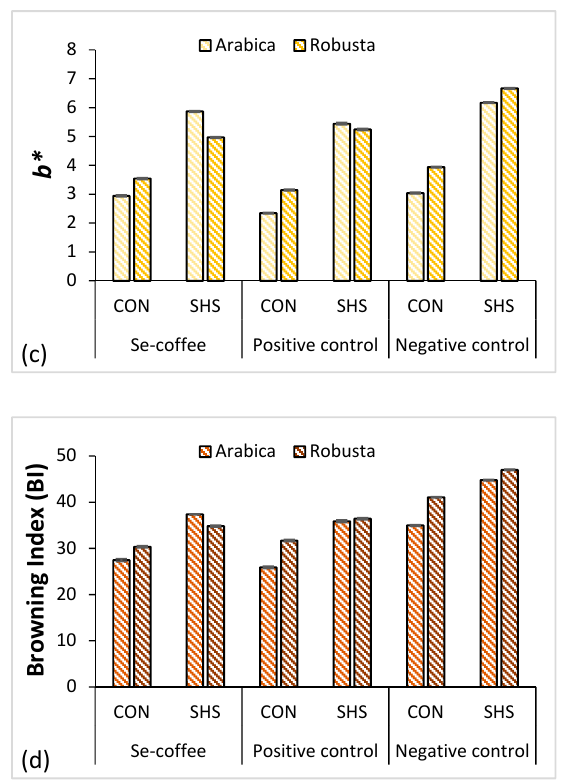
Figure 4. Chromatic parameters ( a ) L* , ( b ) a* , ( c ) b* , and ( d ) browning index (BI) of Arabica and Robusta ground Se-coffee (pretreated with selenium), positive control (pretreated without selenium), and negative control (untreated) roasted via conventional (CON) and superheated steam (SHS) roasting.